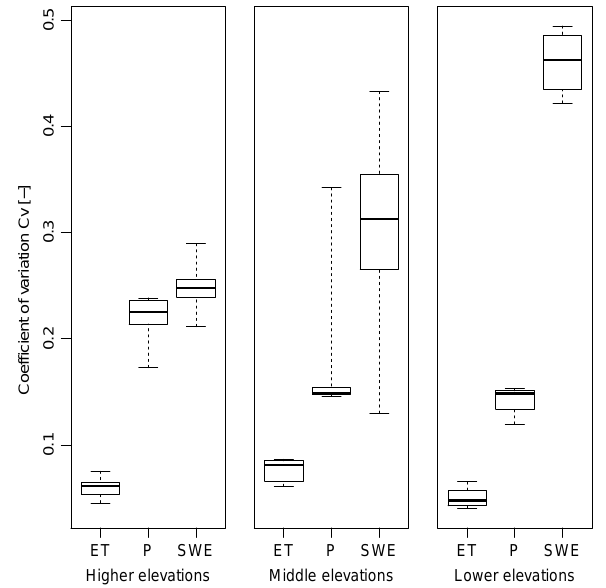
Figure 10. Inter-annual variability of seasonal actual evapotranspi- ration (ET), seasonal precipitation ( P ) and maximum SWE eval- uated by the coefficient of variation, C v . The catchments were grouped by elevation; left, higher elevations: catchments with mean elevation higher than 2000ma.s.l.; middle, middle elevations: catchments with mean elevation between 1300 and 2000ma.s.l.; right, lower elevations: catchments with mean elevation between 850 and 1300ma.s.l. The boxes represent the 25 and 75% quan- tiles, with the thick line showing the median, and the whiskers rep- resent minimum and maximum